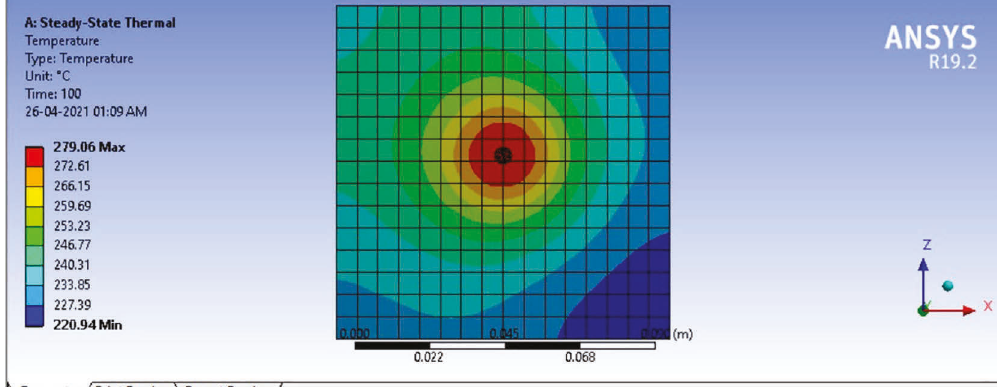
Figure 12: Temperature distribution with a hardened H13 steel tool round pin profile when tool temperature was 278.6 ° C.